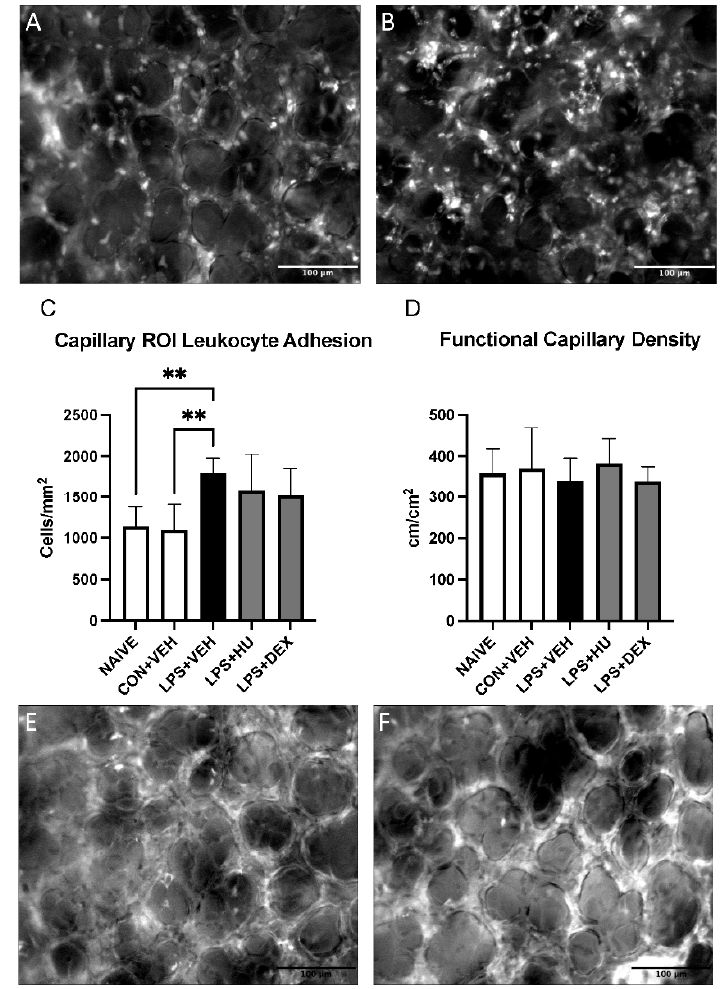
Figure 8. Impact of LPS-induced ALI and treatment on pulmonary capillaries. Representative images of leukocyte adhesion in capillary ROI in ( A ) con + veh mice and ( B ) LPS + veh mice. ( C ) Analysis of leukocyte adhesion in capillary ROI. ( D ) Analysis of FCD in capillary ROI. Representative images of FCD in capillary ROI in ( E ) con + veh mice and ( F ) LPS + veh mice. Data are expressed as mean ± SD. Statistically significant differences were determined via one-way ANOVA with Dunnett’s multiple comparisons test and are depicted as ** p ≤ 0.01.